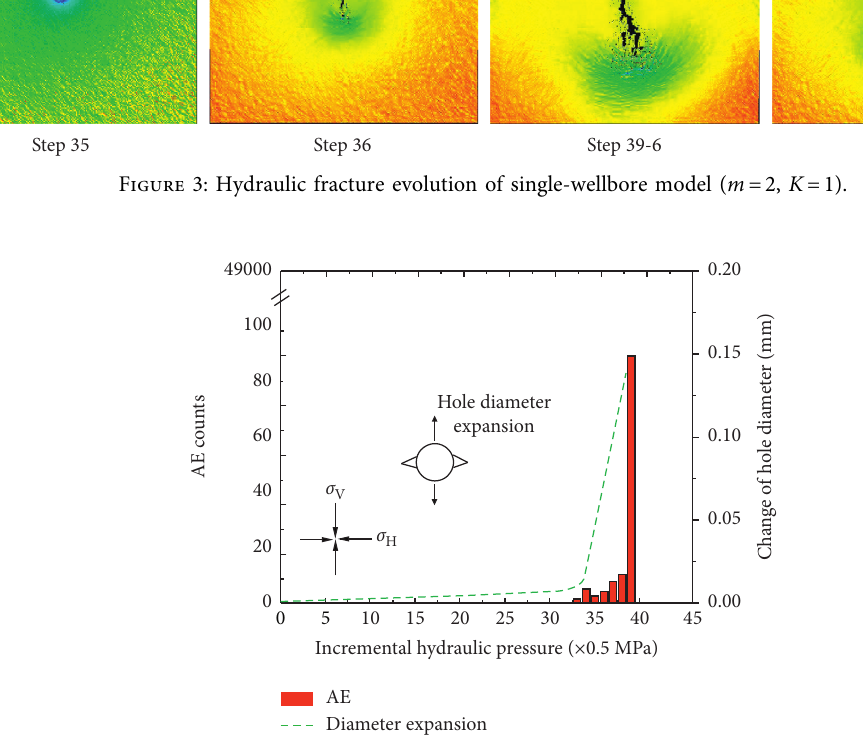
Figure 4: Relationship between hydraulic pressure increment and AE and radius increment for the single-wellbore model.